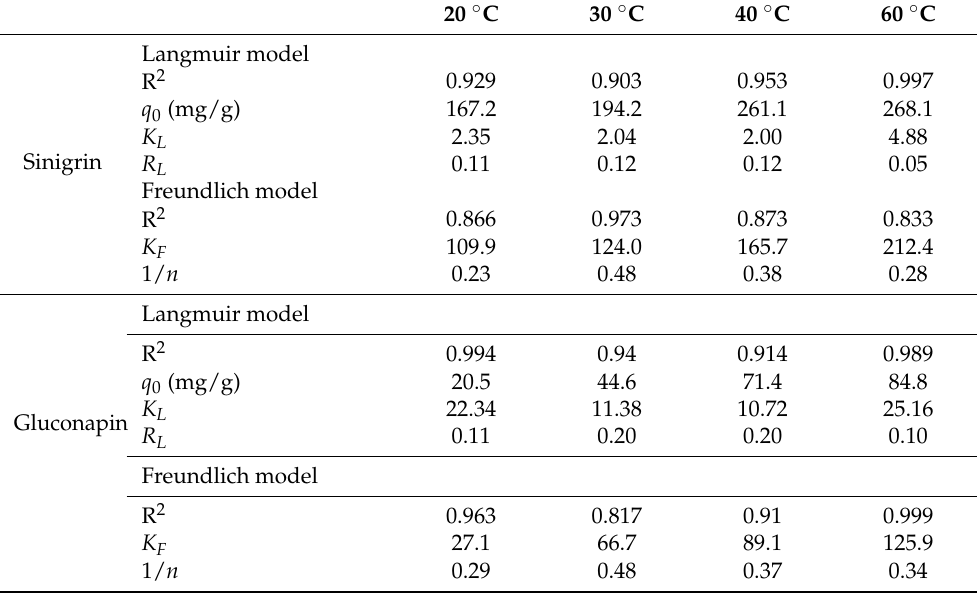
Table 3. Langmuir and Freundlich adsorption parameters of sinigrin and gluconapin using PA312LOH resin at different temperatures in the range 20–60 ◦